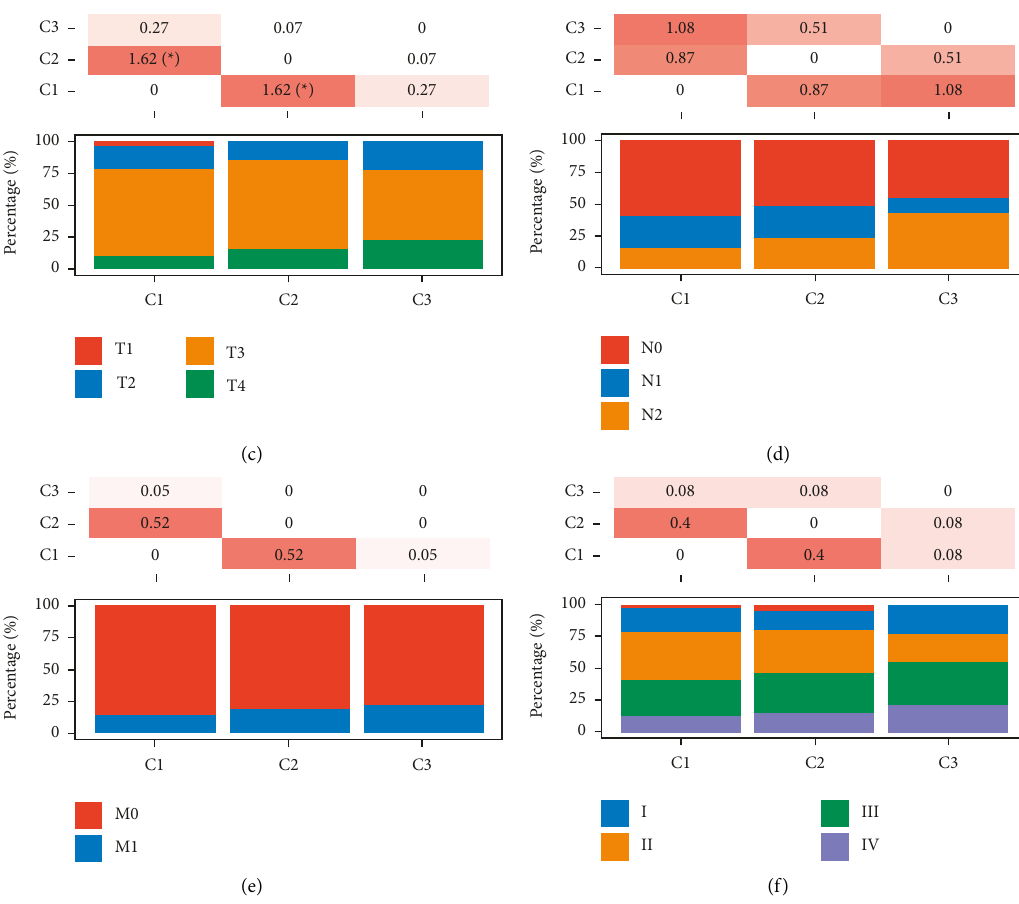
Figure 5: Clinicopathological features analysis of somatically mutated genes related subgroups of CRC. (a) Heatmap showing the expression levels of somatically mutated genes in subgroups of CRC. (b) Kaplan–Meier survival analysis of the correlation between subgroups and PFS time in CRC. (c) The distribution analysis of T stage in different subgroups of CRC. (d) The distribution analysis of N stage in different subgroups of CRC. (e) The distribution analysis of M stage in different subgroups of CRC. (f) The distribution analysis of grades in different subgroups of